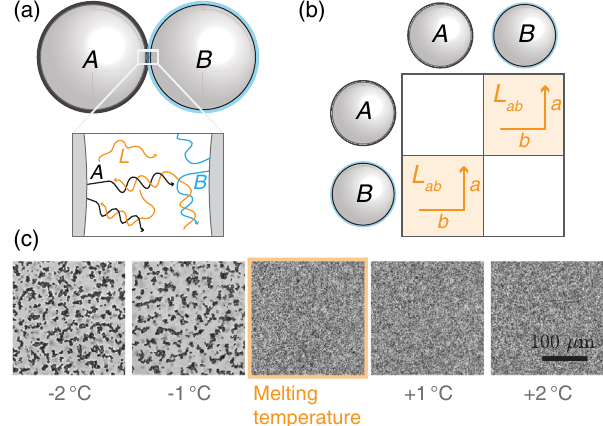
FIG. 1. Linker-mediated binding. (a) Our experimental system is comprised of three DNA sequences: Strands A and B are grafted to 1 - μ m-diameter colloidal particles, and strands L ab , which bind A to B , are dispersed in solution. (b) These three DNA sequences produce a symmetric interaction matrix, in which the linker encodes the pair interaction between particles A and B . (c) The resulting phase behavior is temperature dependent: The system phase separates upon decreasing temperature, as shown by optical micrographs. We define the melting temperature ( T m ) as the temperature at which 50% of the particles are unbound. Experiments are for a 19-nucleotide linker at a concentration of 1 μ M; the melting temperature is 43